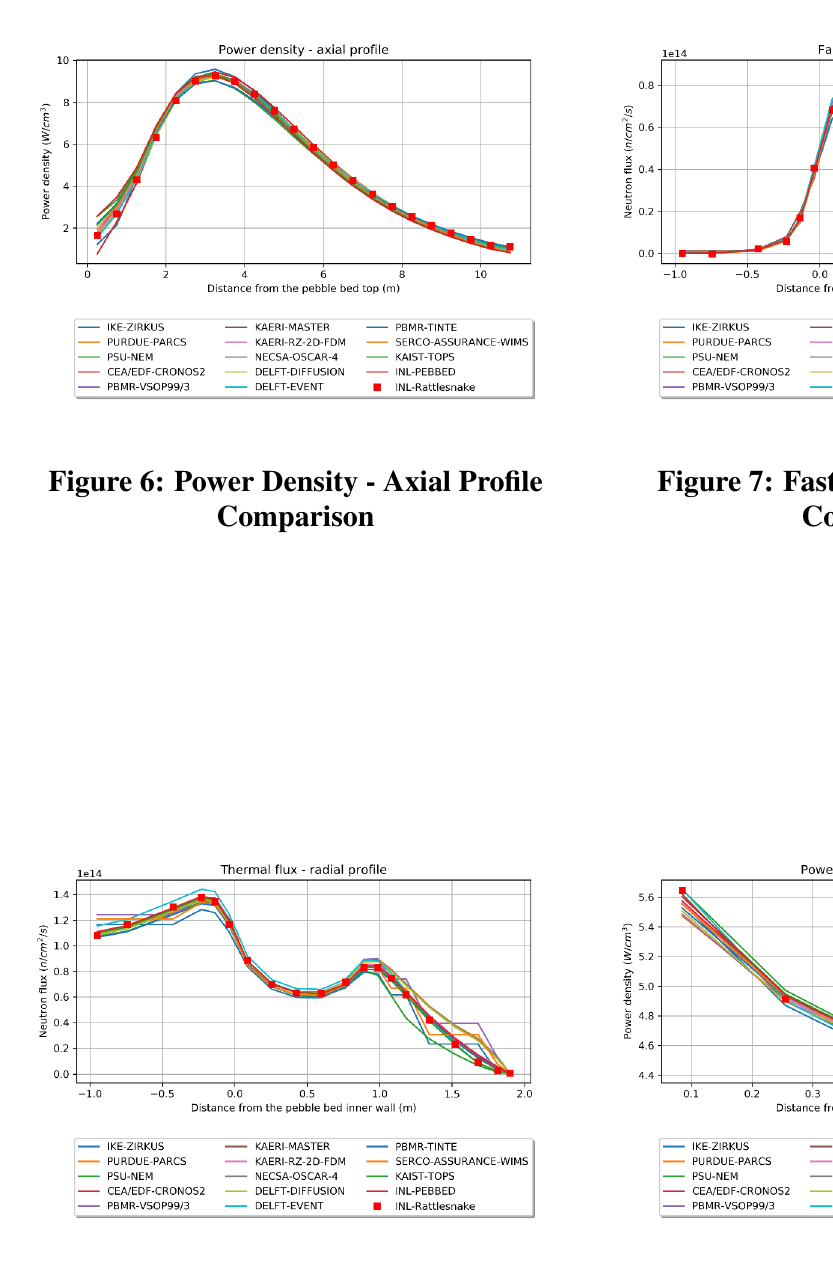
Figure 9: Power Density - Radial Profile